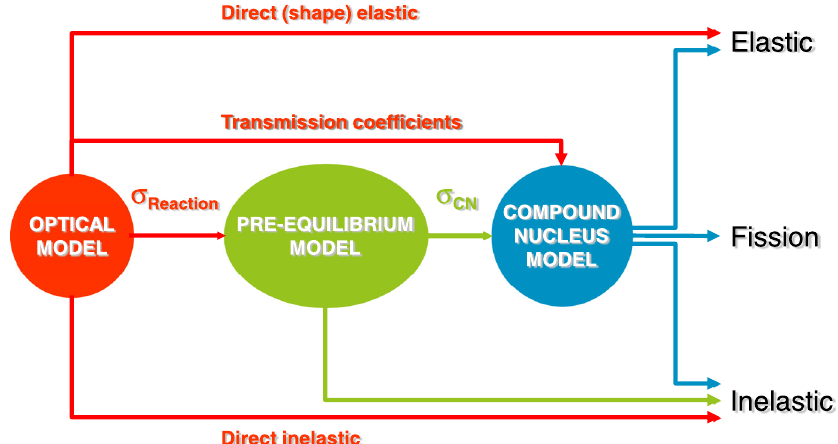
Fig. 1. Flowchart of the sequence of models required to describe a nuclear reaction. The optical model enables to separate the incident fl ux (total cross-section) in three separate contributions (the shape elastic, the reaction and the direct inelastic cross-sections) and provides the compound nucleus with light particles transmission coef fi cients. Part of the reaction cross-section ( s Reaction ) is then processed with the pre-equilibrium model to feed inelastic channels as well as the compound nucleus model with the remaining fl ux ( s CN ). s CN is then spread over all outgoing channels by the compound nucleus model.